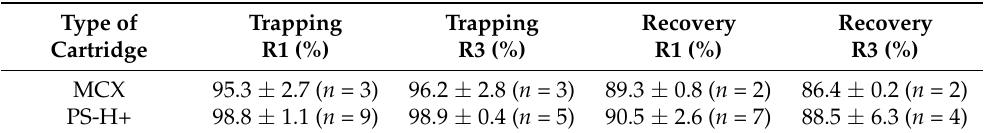
Table 3. Comparison of trapping and recovery efficiency of 68 Ga 3+ using different chambers and SPE resins. Type of Trapping Trapping Recovery Recovery Cartridge R1 (%) R3 (%) R1 (%) R3 (%) MCX 95.3 ± 2.7 ( n = 3) 96.2 ± 2.8 ( n = 3) 89.3 ± 0.8 ( n = 2) 86.4 ± 0.2 ( n = 2) PS-H+ 98.8 ± 1.1 ( n = 9) 98.9 ± 0.4 ( n = 5) 90.5 ± 2.6 ( n = 7) 88.5 ± 6.3 ( n = 4)